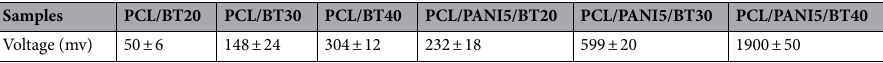
Table 4. Output voltage of nanocomposites with 20, 30, and 40 wt.% BT and Output voltage of ternary nanocomposites with 20, 30, and 40 wt.% BT and 5 wt.% PANI.